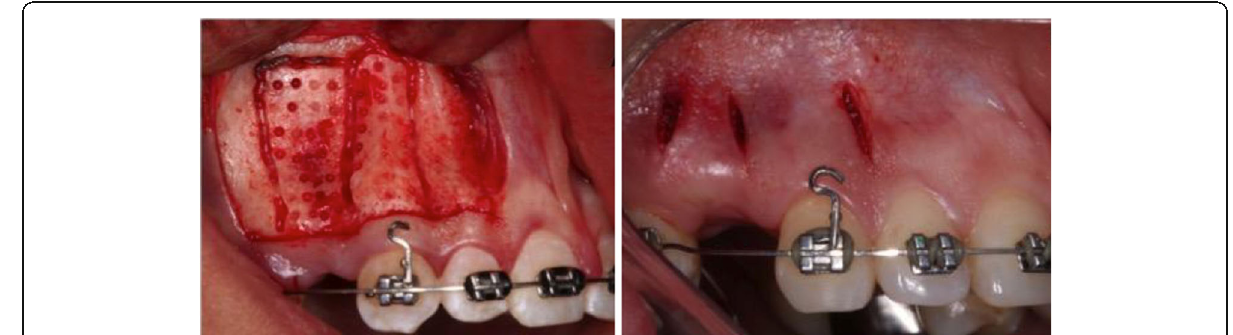
Fig. 2 Surgical procedures. A Alveolar corticotomy; B piezocision